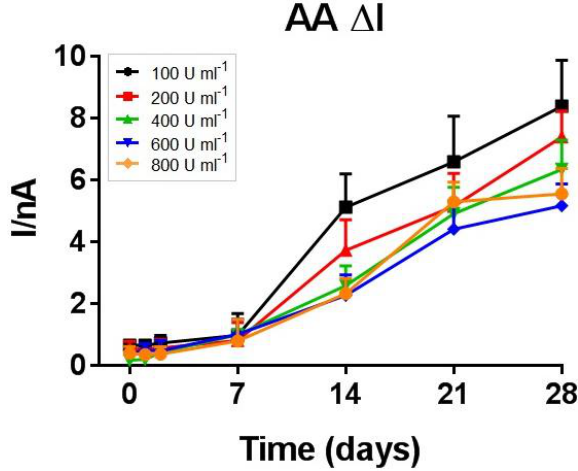
Figure 4. In-vitro stability study: evolution of the AA ΔI, over a 28 days monitoring period for biosensors fabricated from different enzyme loading solutions ( n = 4 for each group).